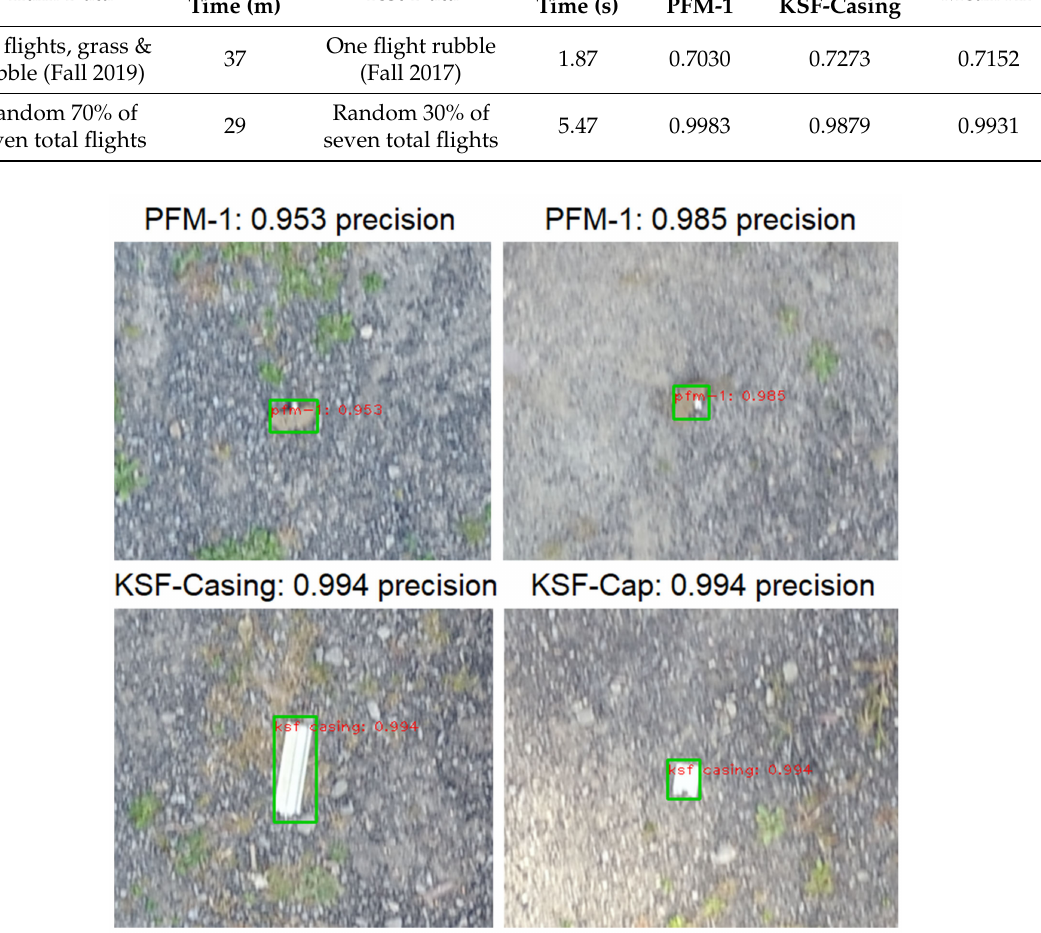
Figure 10. AP for two PFM-1 landmines, one KSF-Casing, and one KSF-Cap in testing